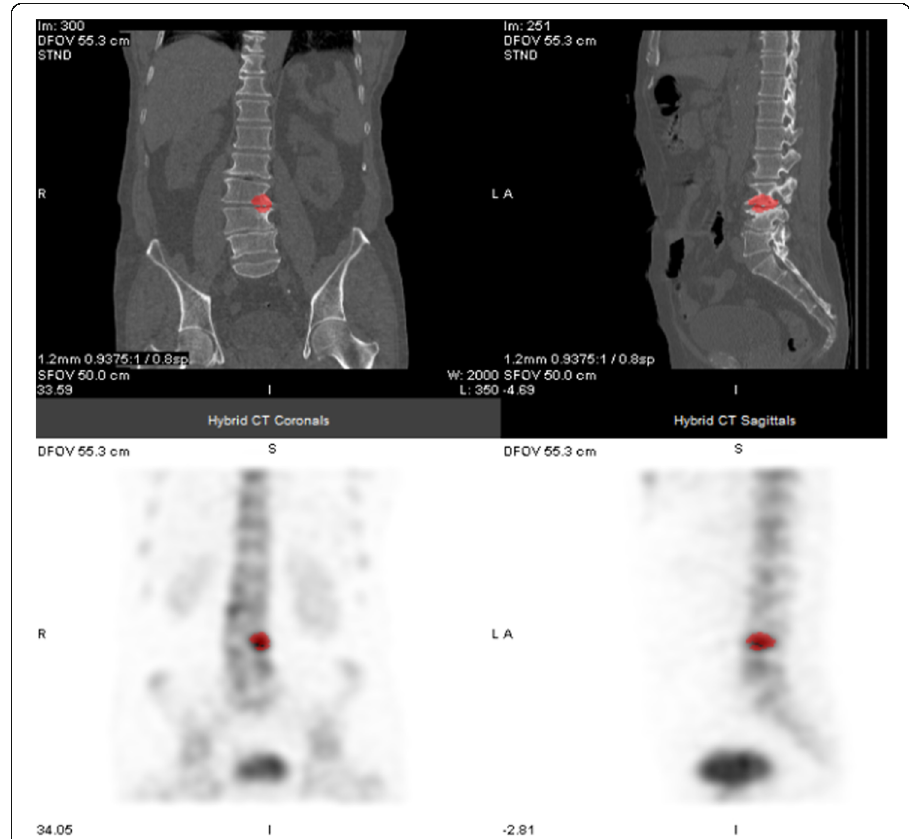
Fig. 5 A local case study. Using GE ’ s Q.Volumetrix MI (GE Healthcare) the SUV max at the confirmed site of fusion in the lumbar spine was found to be 28.7 (SUV mean = 15.4), which sits comfortably above Kuji et al. ’ s normal range (but also within the range derived for metastases) (Kuji et al. 2017). The SUV mean across all CT- segmented bone in the field of view was 3.48, which was lower than expected according to Kaneta et al. ’